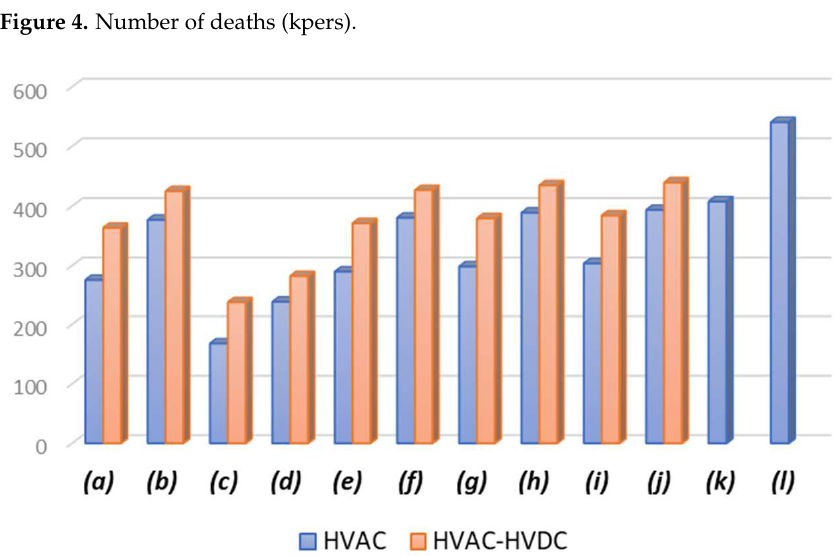
Figure 5. Reserve margin (GW).